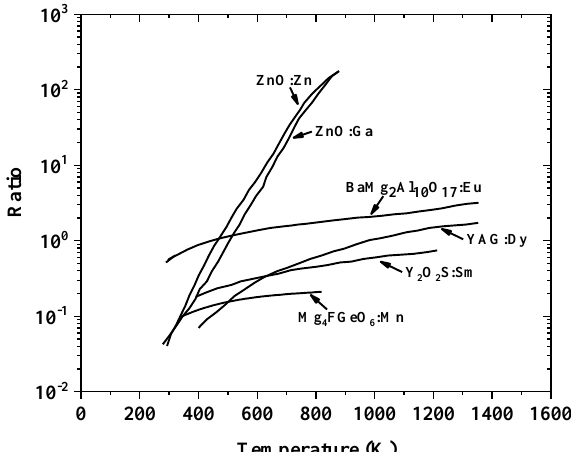
Figure 12. Spectral intensity ratio of different phosphors used in laser-induced phosphorescence technique [34,89].